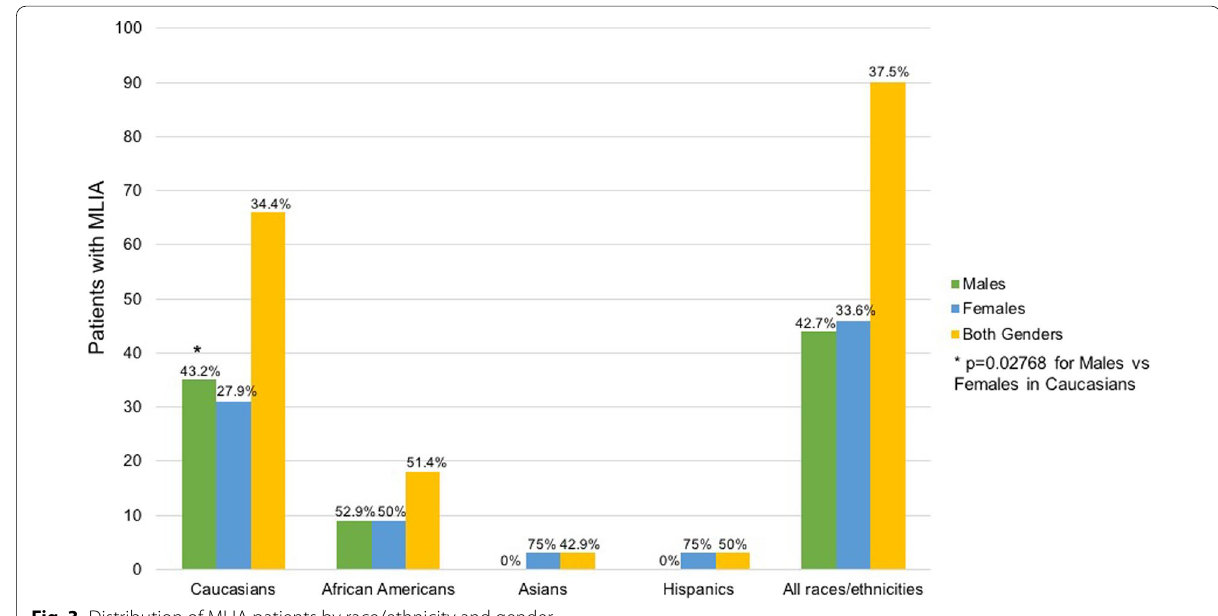
Fig. 3 Distribution of MLIA patients by race/ethnicity and gender